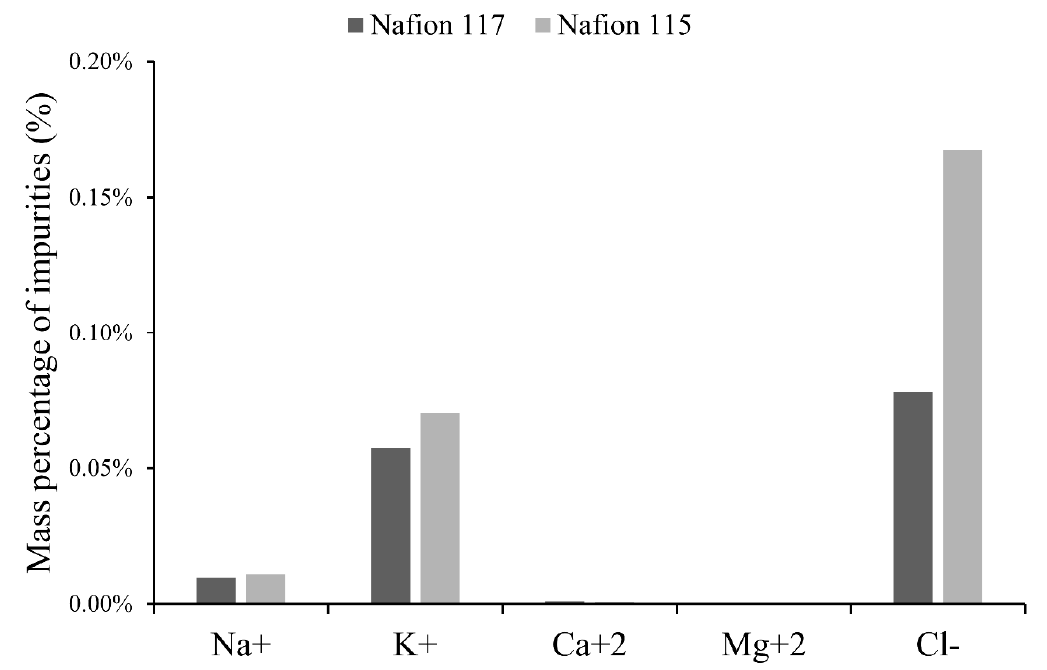
Figure 9. Mass of other ions in the catholyte according to type of membrane.